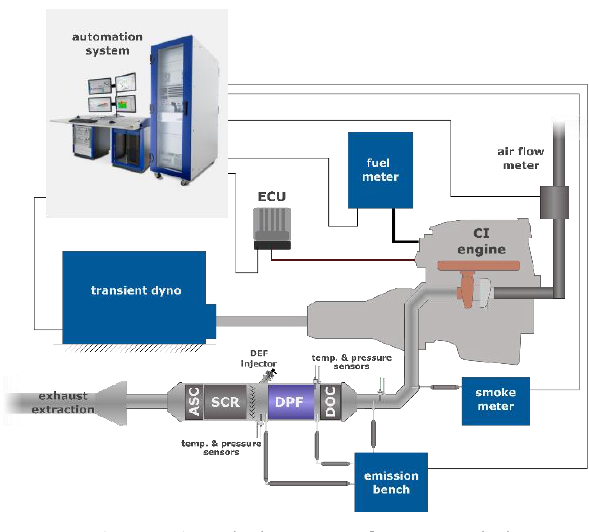
Fig. 1. Engine and exhaust system layout on test bed